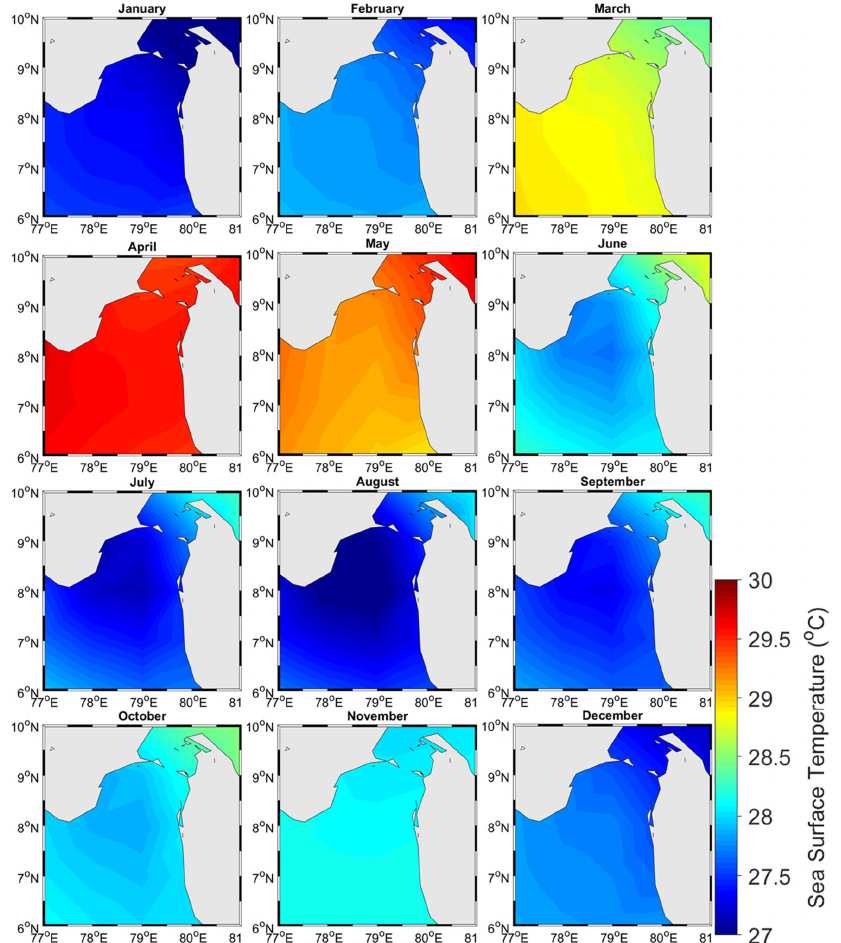
Figure 9. Spatial variation of average SSTs in the GoM from 1870 to 2018.